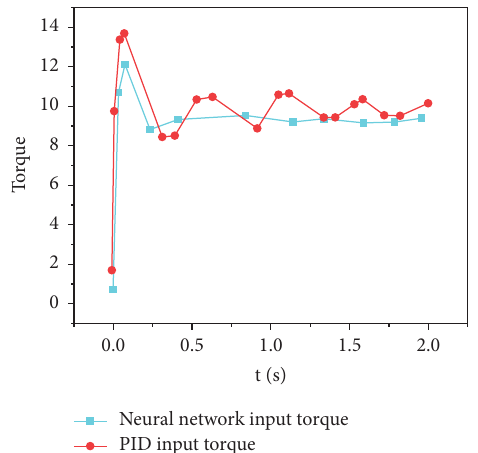
Figure 4: Torque control of robot arm 3 (no external interference).